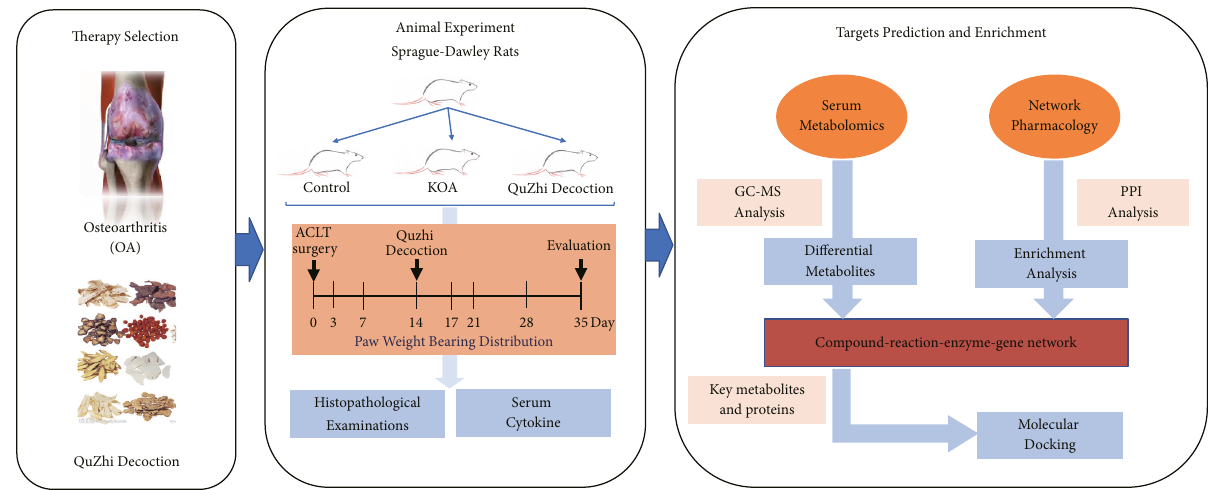
Figure 1: Quzhi decoction was used to treat osteoarthritis in the current article (therapy selection); the influence of Quzhi decoction on pain-like behavior and joint inflammation in knee OA rats (animal experiment); integrated serum metabolomics and network phar- macology to reveal the interventional effects of Quzhi decoction against osteoarthritis (targets prediction and Table 1: Herbs in Quzhi decoction.